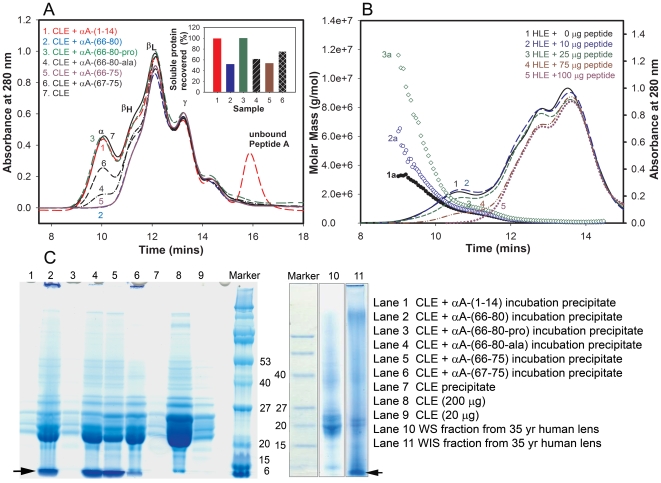
The αA-(66-80) peptide–induced aggregation and precipitation of crystallins.(A) Size-exclusion column elution profiles of soluble crystallins from WS CLE (200 µg) following incubation with or without different synthetic peptides (100 µg) for 16 hrs at 37°C. The chromatography was performed using a TSK G5000PWXL column (7.8 mm×30 cm) and the elution was monitored using a 280 nm absorption detector. The inset in the figure shows the amount of soluble protein recovered after peptide treatment and centrifugation at 3000 rpm for 10 min. Samples 1-7 in the inset correspond to samples 1-7 analyzed by the size-exclusion column. The results show that the effect of αA-(66-80) peptide is sequence specific. The addition of αA-(66-80), αA-(66-75) and αA-(67-75) peptides, present in human lens WIS fractions, causes precipitation of crystallins when incubated with CLE. (B) Effect of the peptide on 35-year-old human lens crystallins. HLE (190 µg) was incubated with various amounts of synthetic αA-(66-80) peptide for 16 h at 37°C. The samples were centrifuged, and the supernatants were chromatographed on a TSK G5000PWXL column connected to a multi-angle light scattering instrument (Wyatt Technology). Lines 1a, 2a and 3a show the distribution of molecular mass across the UV profile of samples 1, 2 and 3, respectively. Mass profiles of samples 4 and 5 could not be analyzed due to instrument limitations. The results show that the presence of increased amounts of αA-(66-80) peptide in the incubation mixture leads to increased aggregation, light scattering and precipitation. (C) SDS-PAGE analysis of precipitates of CLE and αA-derived peptides or substituted αA-peptides from panel A and the WS and WIS fractions from a 35-year-old human lens. The left arrow on lane 1 points to the precipitation of test peptides with crystallins and the right arrow on lane 11 points to the presence of peptides in human WIS fraction. The results of SDS-PAGE analysis show the precipitate formed when αA-crystallin-derived peptides are incubated with CLE that contains both the lens crystallins and the peptide tested. The data also confirm the presence of LMW protein fragments in the WIS fraction from human lenses.